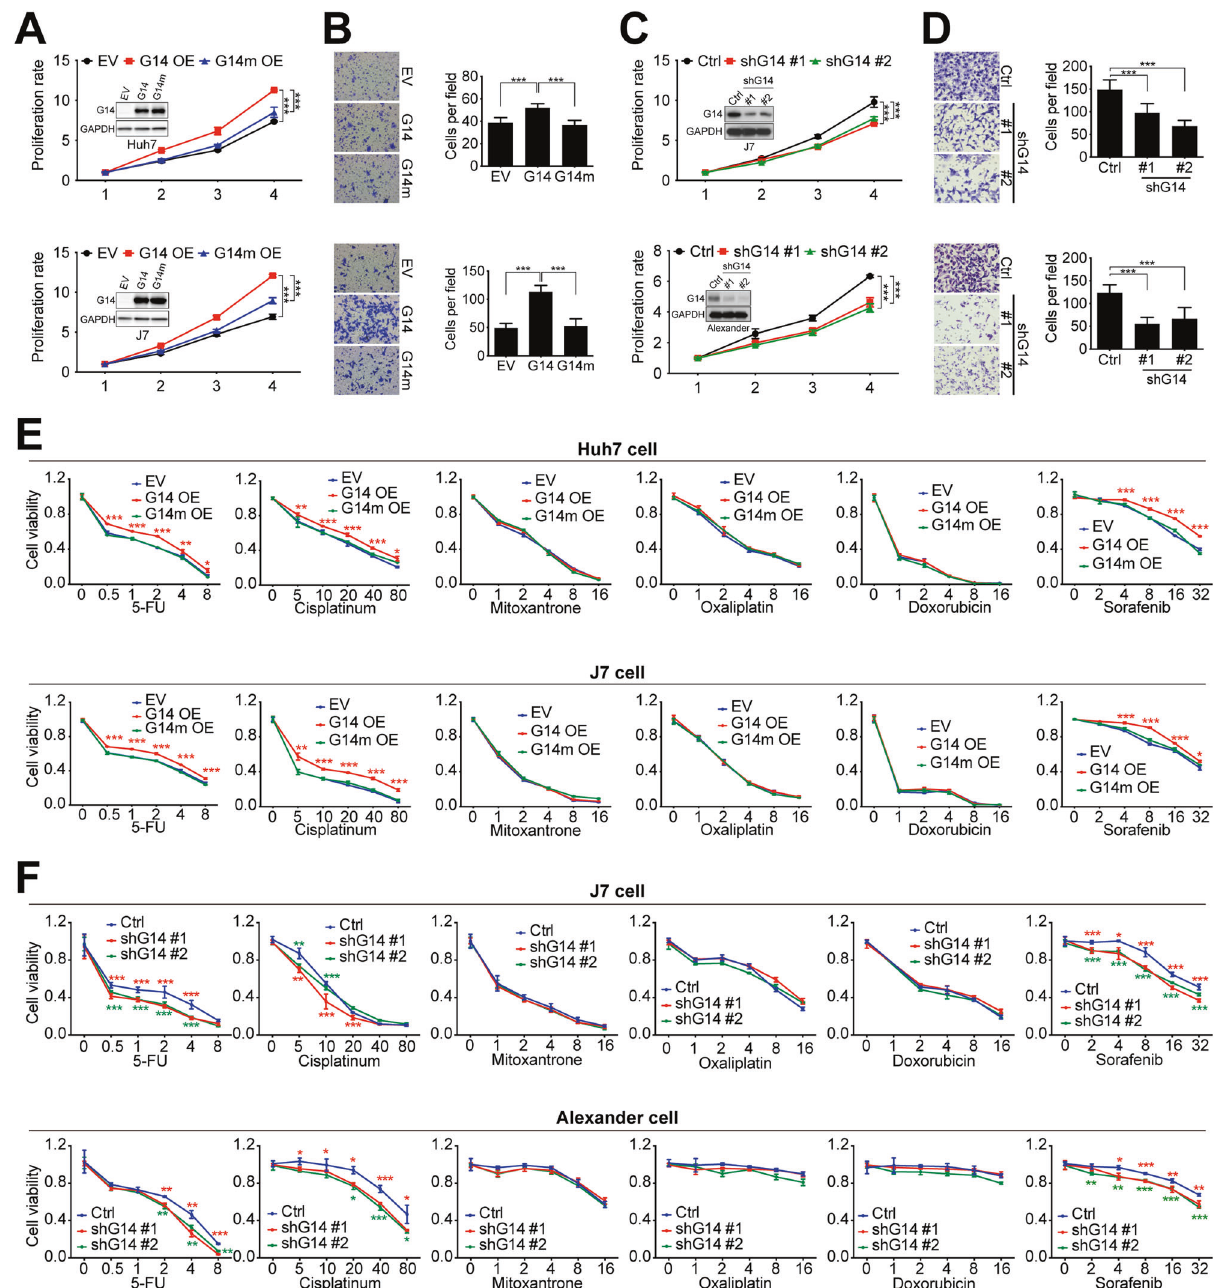
Fig. 2 Altered expression of GALNT14 affects the growth, migration, and sensitivity of HCC cells to anticancer drugs. A Cell proliferation rate of mock cells (EV), cells overexpressing GALNT14 (G14 OE), and cells overexpressing the GALNT14 mutant (G14m OE). The latter carried three enzyme-inactivating mutations. P values were calculated by two-way ANOVA. Western blot images are inserted to demonstrate overexpression of GALNT14 or GALNT14 mutant. Horizontal axis, days after cell seeding; vertical axis, fold increase normalized to day 1 value. B Representative images of transwell assays for HCC cells, Huh7 (upper) and J7 (lower), with or without overexpression of GALNT14 (or GALNT14 mutant). Quantitative results are displayed in the right panel. P values were calculated by paired two-tailed student ’ s t test. C Cell proliferation rate of HCC cells with or without GALNT14 silencing. P values were calculated by two-way ANOVA. Western blot images are shown indicating successful silencing of GALNT14. These blots were overexposed to demonstrate endogenous GALNT14. D Representative images of transwell assays for the HCC cells, Huh7 (upper) and J7 (lower), with or without GALNT14 silencing. Quantitative results are displayed in the right panel. P values were calculated by paired two-tailed student ’ s t test. G14 GALNT14, Ctrl mock control for shRNA (shLacZ). E , F Relative cell viability of HCC cells treated with anticancer drugs. E Evaluation of the sensitivity of cells overexpressing GALNT14 (G14 OE) or GALNT14 mutant (G14m OE) to anticancer drugs 5-FU (in mg/mL as marked in the horizontal axis), Cisplatin (in μ g/mL), Mitoxantrone (in μ g/ mL), Oxaliplatin (in μ g/mL), Doxorubicin (in mg/mL), and Sorafenib (in μ M). F A similar assessment was performed on cells with GALNT14 silencing. Vertical axis, relative fold change normalized by the value of concentration “ 0 ” . P values at each concentration were obtained by comparing cells transfected with empty vector (EV) or control shRNA (Ctrl), and cells transfected with G14/G14m or shG14 #1/2. Unpaired two-tailed student ’ s t test was used. * P < 0.05; ** P < 0.01; *** P < 0.001.